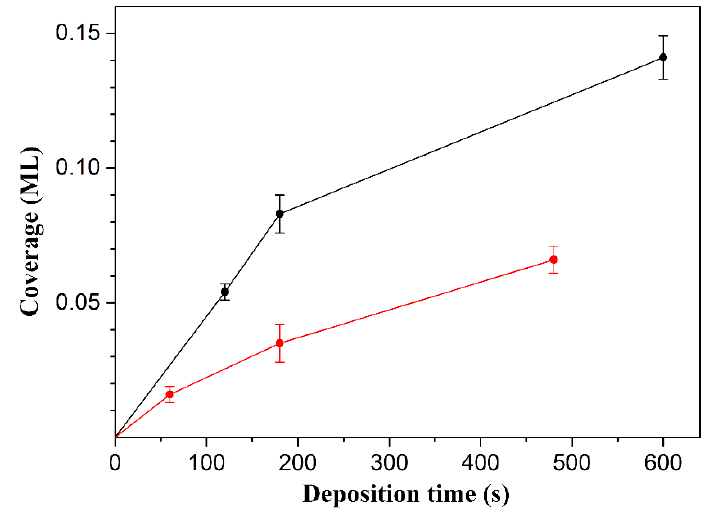
Figure 4. The average coverage as a function of the deposition time of glycine (black) and proline (red) molecules onto the Ge(100) surface. The error bars exhibit the 95% confidence interval.